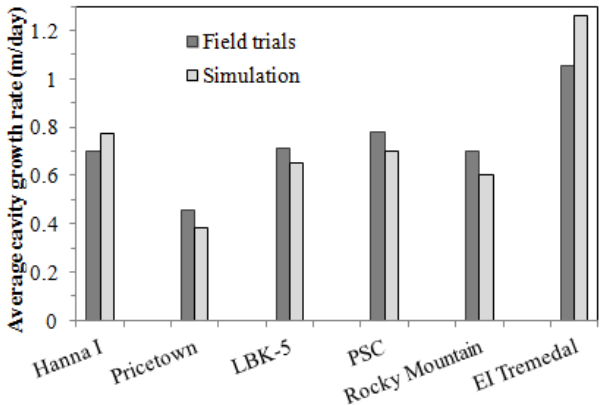
Figure 45. Comparison of estimated cavity growth rates from six UCG field trials with model simulations [80].